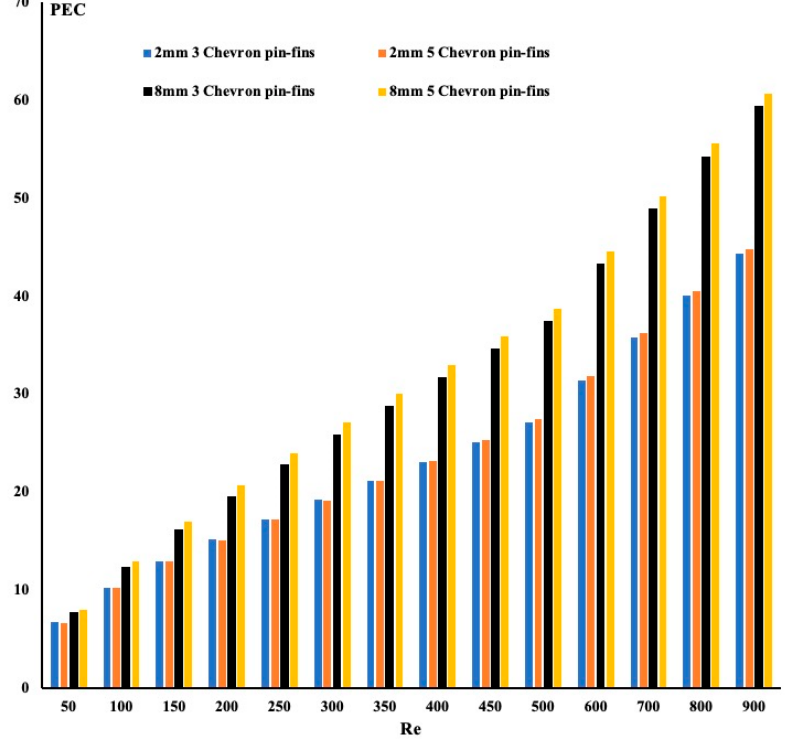
Figure 5. Performance evaluation criterion for solid pin-fins.